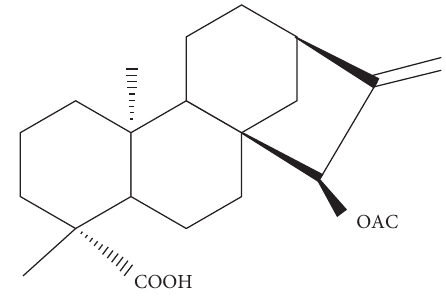
Figure 1: Chemical structure of xylopic acid